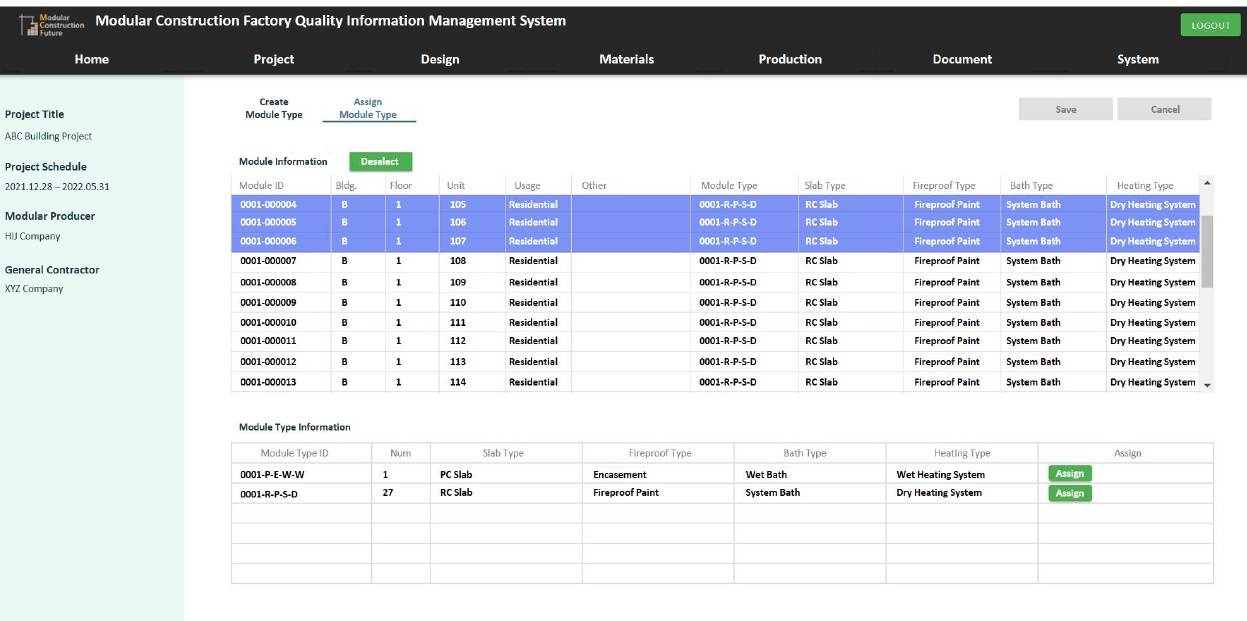
Figure 6. Module type information designation function.